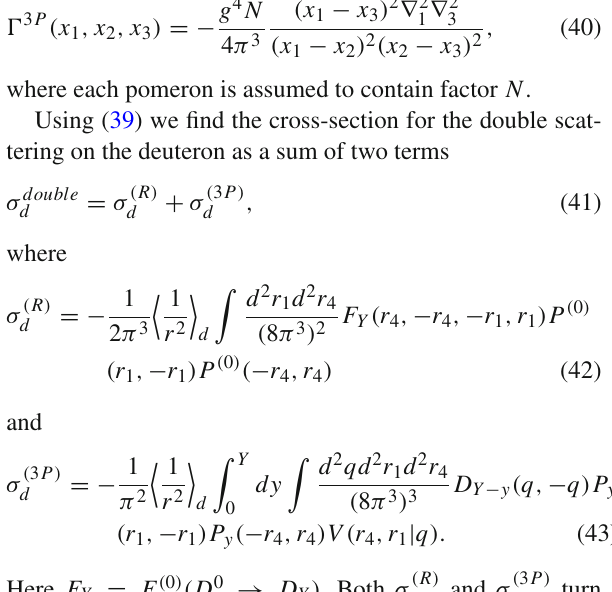
The two parts H ( R ) and H ( 3 P ) behave differently at high energies: The so-called reggeized piece H ( R ) is shown in Fig. 9. Integrated over e − it is just the impact factor F ( 0 ) for the four reggeons attached to the projectile in which all functions D ( 0 ) are substituted by their evolved expressions D Y with all their arguments retained. The second part D ( 3 P ) isgivenby(38)inwhichthediffractivevertex Z issubstituted by the standard triple pomeron vertex V . The latter can be conveniently written in the coordinate space